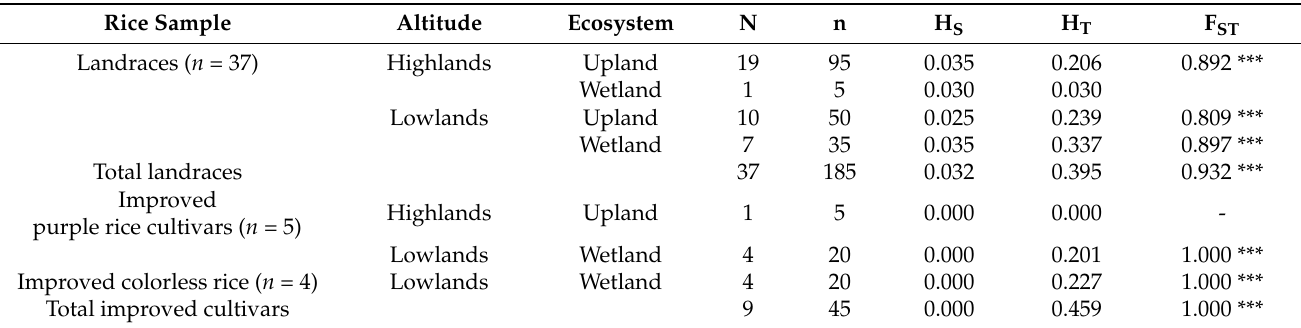
Table 2. Genetic diversity and genetic differentiation within and between populations of purple rice in northern Thailand, by altitude and ecosystem.